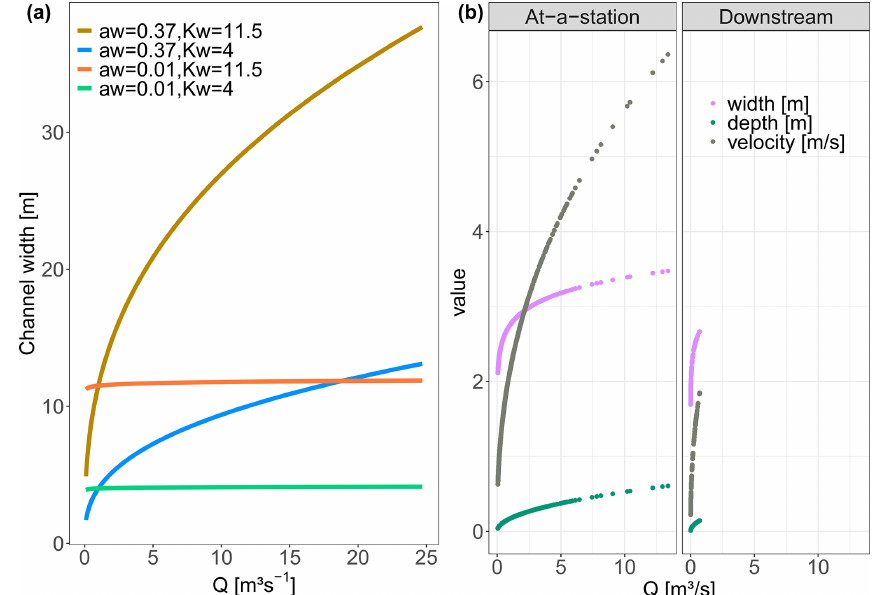
Figure B3. (a) The effect of parameters a w and K w on the channel width illustrated for the Q time series at the Selke Meisdorf station. (b) In the “At-a-station” panel the changes in velocity, depth and width with Q for grid cell B (Fig. 3) in the middle of the Selke network are evaluated. The “Downstream” panel, which considers all the network grid cells, shows the channel characteristics width, depth and velocity for a time t , with a Q of 0.70m 3 s − 1 at the outlet. The values for the parameters a w , K w , a d and K d are the same for both scenarios (Table C1).